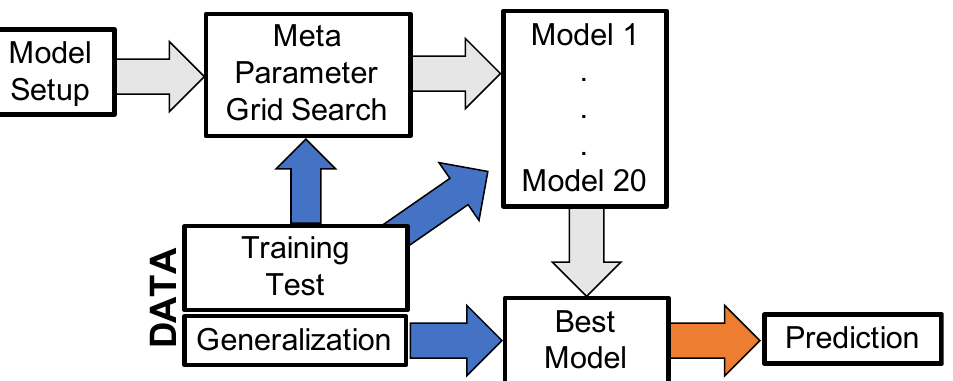
Figure 5. Workflow of model training and selection of the best model run (color of arrows: model selection ( grey ); data flow ( blue ); recall, i.e., application of best model on generalization set ( orange